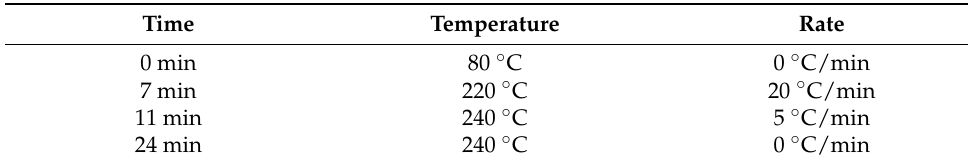
Table 11. GC-MS temperature